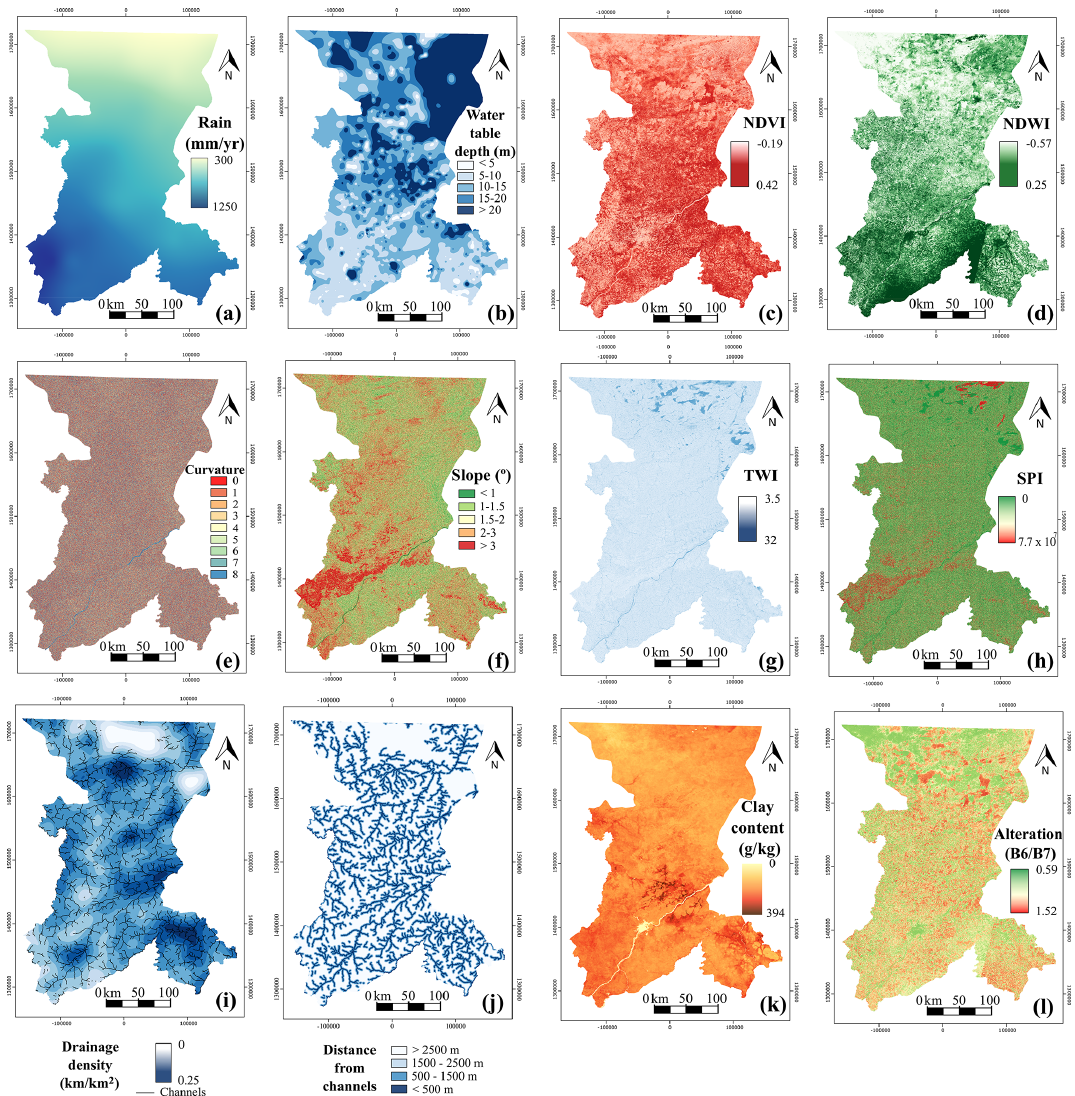
Figure 7. Explanatory variables used to predict the GPM: (a) rainfall (mm/yr) (b) , water table depth (m), (c) normalized difference vegetation index (NDVI), (d) normalized difference water index (NDWI), (e) curvature, (f) slope ( ◦ ), (g) topographic wetness index (TWI), (h) stream power index (SPI), (i) drainage density (km / km 2 ), (j) distance from channels (km), (k) clay content (g/kg) and (l) the alteration band ratio (B6 /